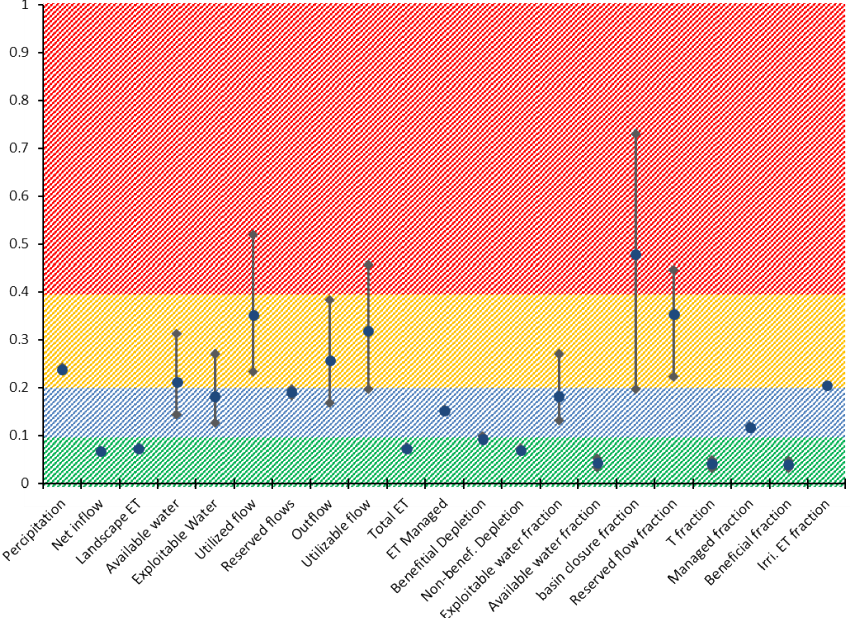
Figure 10. The level of inaccuracy expressed as a coefficient of variation for a dry, a wet and an average rainfall year. The height of the bars expresses temporal variability. The background colors indicate where a certain parameter should be considered in the water management decision